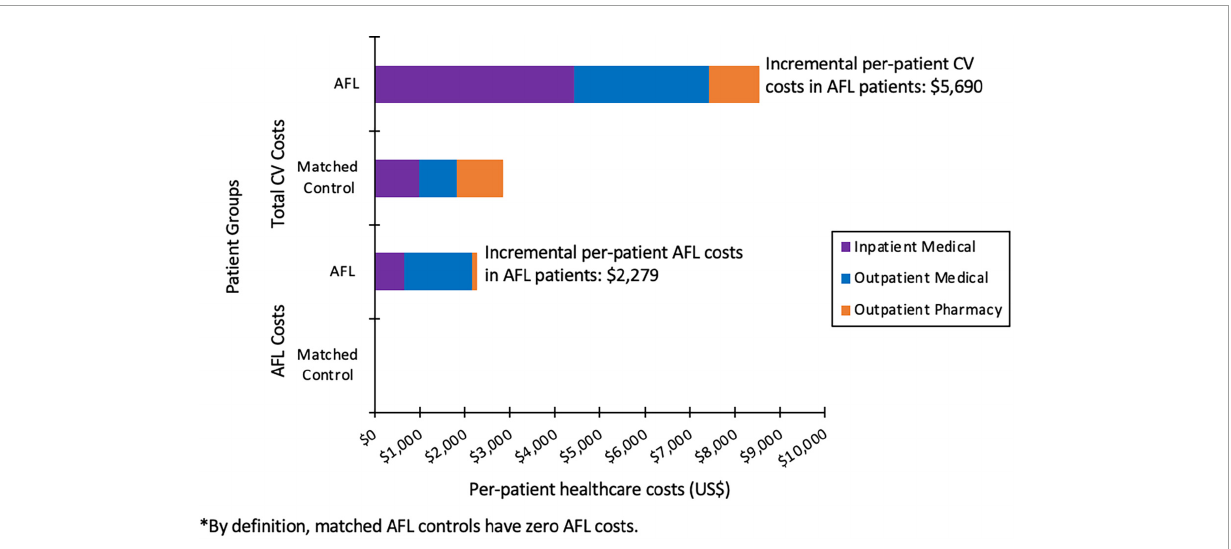
FIGURE2 Total annual CV-specific and AFL-related healthcare costs per